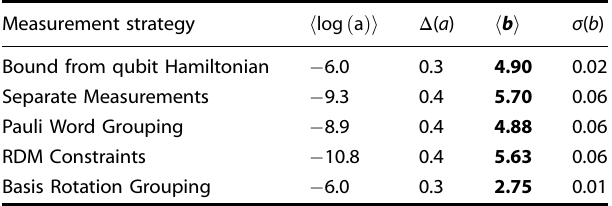
Table 3. Bounds and uncertainties resulting from Bayesian inference using a Monte-Carlo approximation with 10 6 particles for all hydrogen full con fi guration interaction data 48